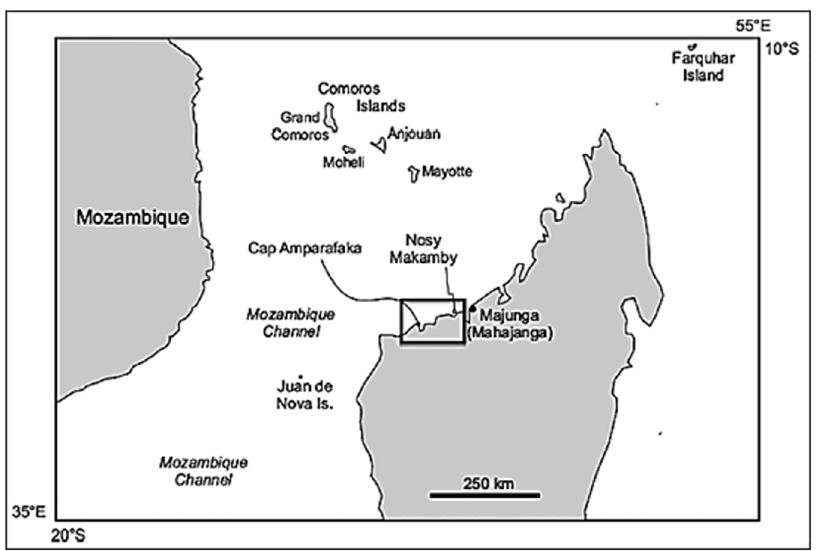
Fig 1. Location of Nosy Makambyoff the northwestern coast of